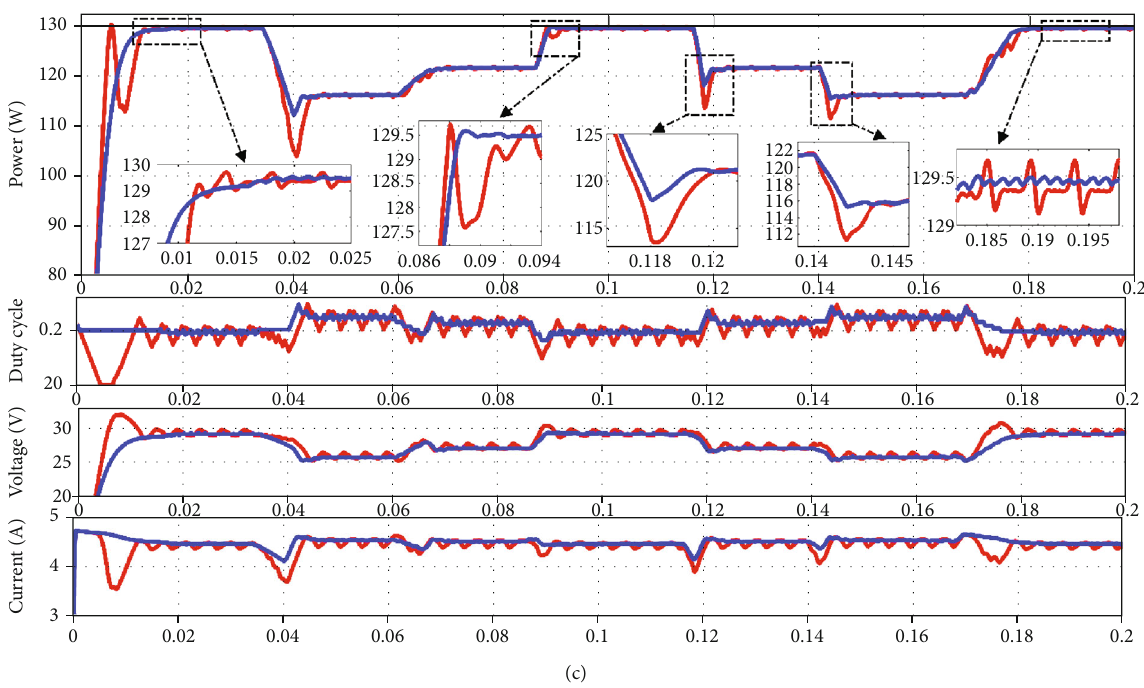
Figure 21: Simulation results from the comparison between the INC and INC-IMP methods under the scenario of temperature variation with constant solar irradiance: (a) 1000W/m 2 ; (b) 800W/m 2 ; (c) 600W/m 2 .